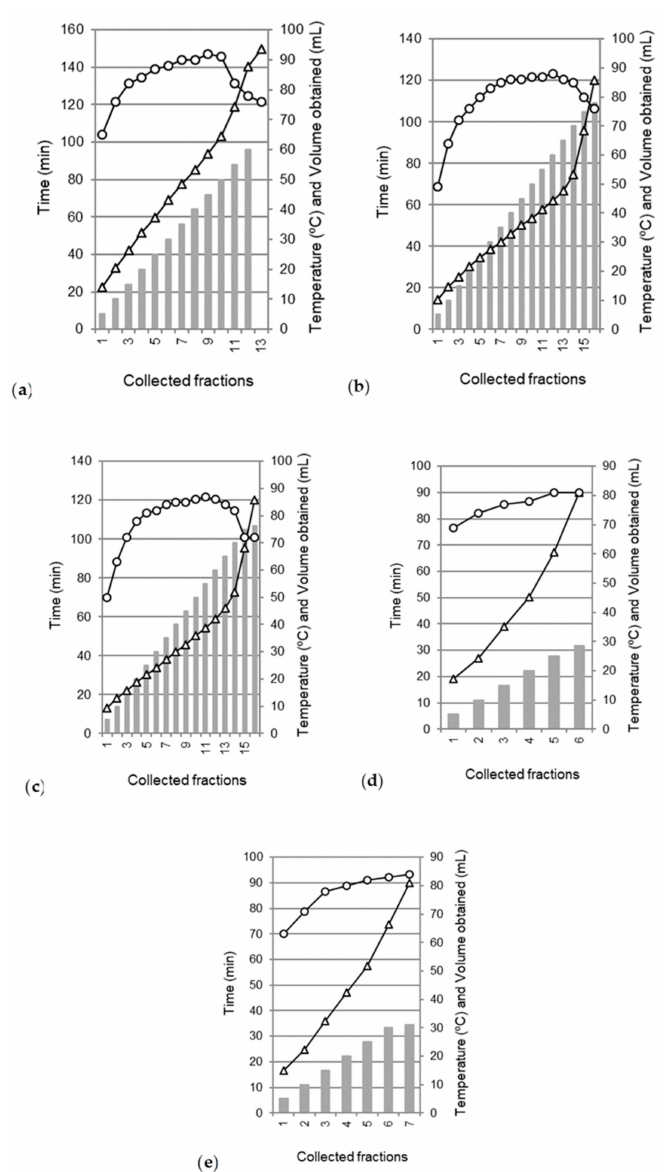
Figure 1. Collected volume (bars), vessel temperature (circles) and extraction time (triangles) during MHG treatment at 100 W of irradiation power of di ff erent raw materials: ( a ) defrosted Cytisus scoparius flowers, ( b ) defrosted fruiting bodies of Pleurotus ostreatus mushrooms, ( c ) defrosted Brassica rapa L. var. rapa leaves, ( d ) whole and ( e ) divided into quarters Quercus robur L. acorns. Note here that y-axes scales are di ff erent in each